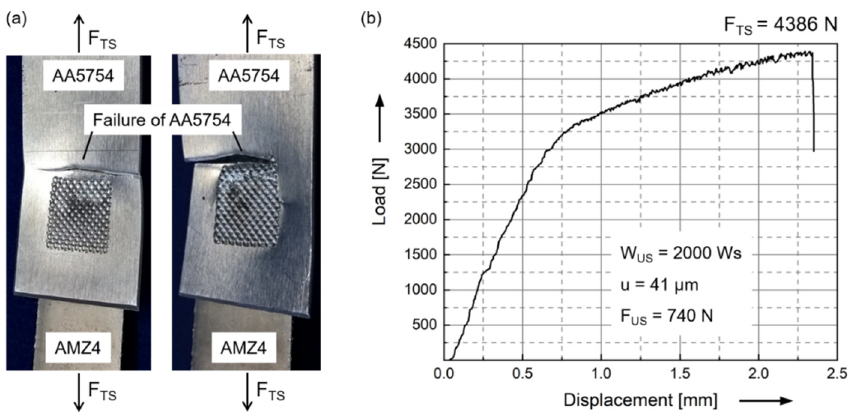
Figure 5. ( a ) Tensile shear tested AA5754/AMZ4 joints revealing the failure of the AA5754 sheet parallel to the edge of the weld spot. Process parameters: welding energy W US = 2000 Ws, displacement amplitude u = 41 µ m and welding force F US = 740 N. ( b ) Characteristic load–displacement diagram of a tensile shear test of an AA5754/AMZ4 joint. Both elastic strain and plastic deformation occur, revealing the PLC effect that is typical for these aluminum alloys.